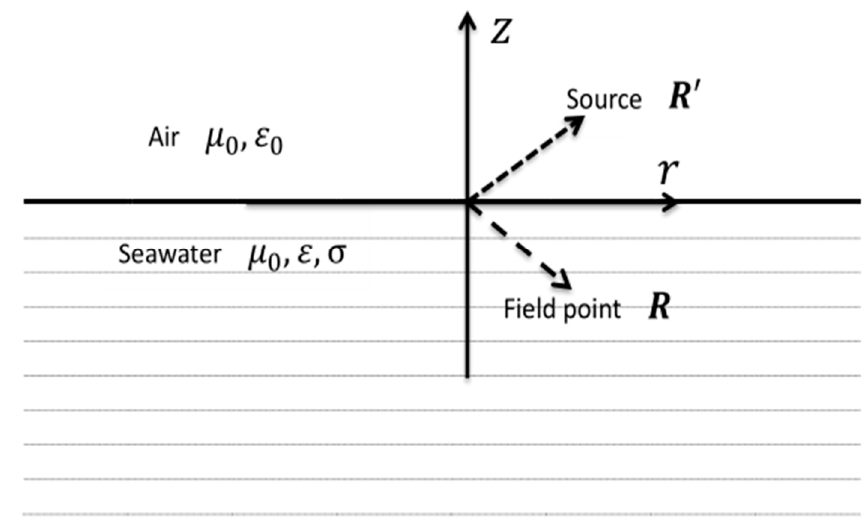
Figure 1. Air-seawater two-layer model in the cylindrical coordinate system.